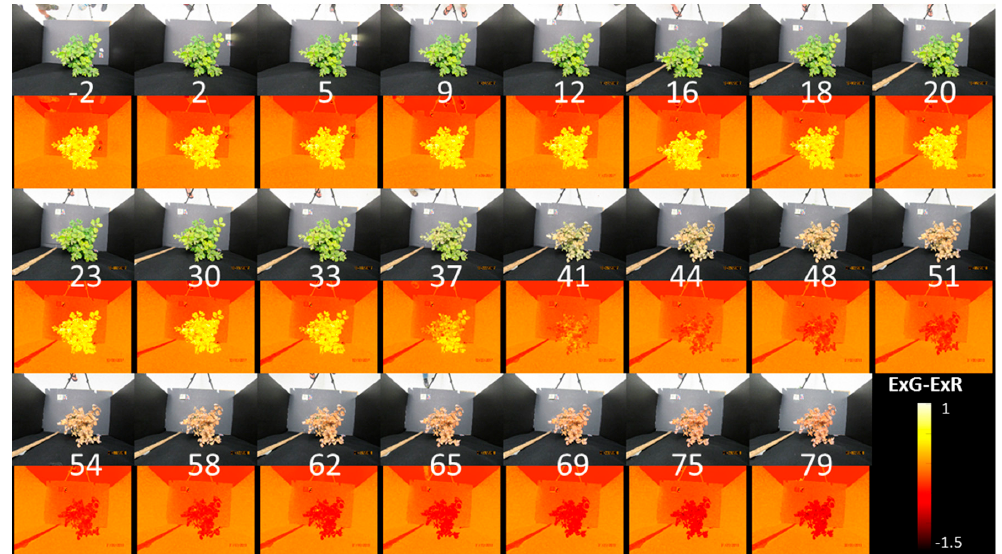
Figure 6. Time series of top-down RGB photos and derived excess green minus excess red (ExG-ExR) images for C. huliohia -inoculated study plant # 8. Days since inoculation shown in white. Similar images were collected for all other plants in the laboratory experiment.